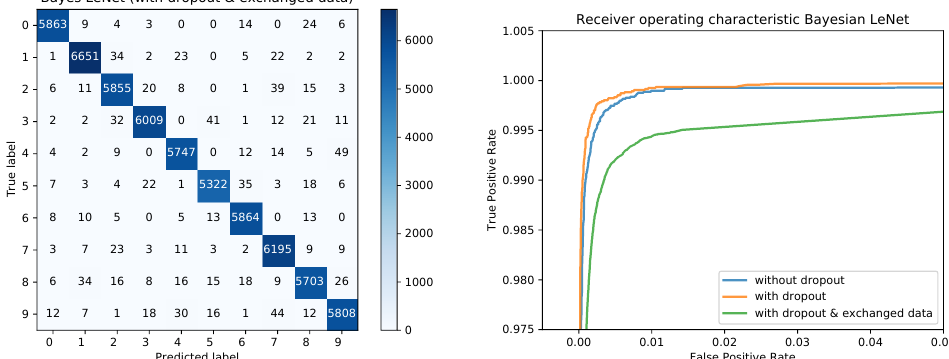
Figure 9. Confusion matrix for the Bayes LeNet with dropout and exchanged data and ROC curves for all three models.